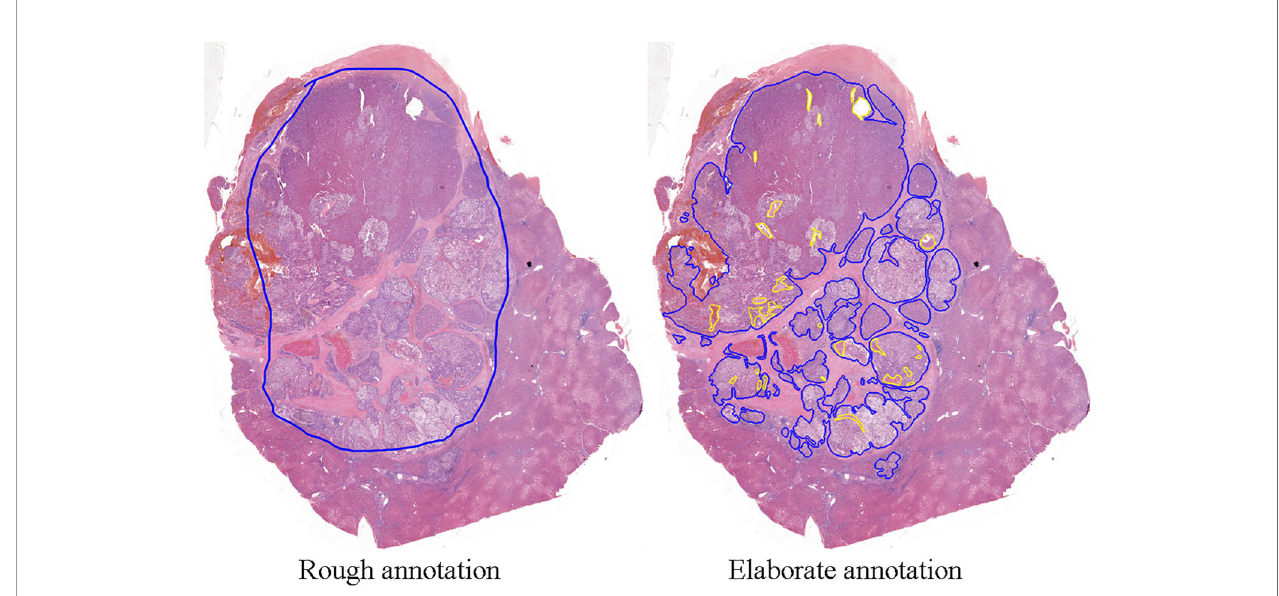
FIGURE 2 | The process of our proposed model. Patches of three scales (×5, ×20, ×50 magni fi cation) were cropped from slides, and the corresponding labels were decided according to annotations. Patches of ×50 magni fi cation are at a large scale containing the clearest cellular features but are also probably noisier. In contrast, ×5 magni fi cation minimizes errors, but the cellular features can be hardly seen. These patches are severally inputted into the main encoder E m and classi fi er to get results. In the other part, the regular labels are transferred into smooth labels to guide the training in our model. Additionally, our model contains a module to get dynamic smoothing weight by the surrounding information of each patch. Here E p denotes the pretrained Autoencoder to generate the feature polymer, which is utilized to output the dynamic smoothing weight ϵ